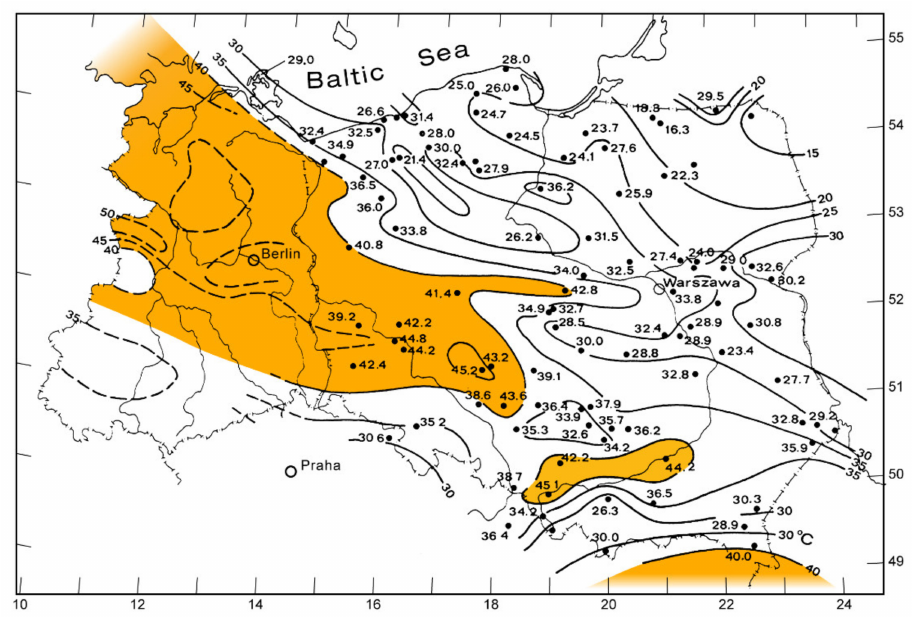
Figure 12. First temperature at 1 km map based Polish and Eastern Germany data redrafted and modified from Majorowicz 1973a, [9].